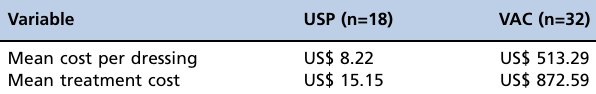
Table 2 - Cost of dressings (US$/day).